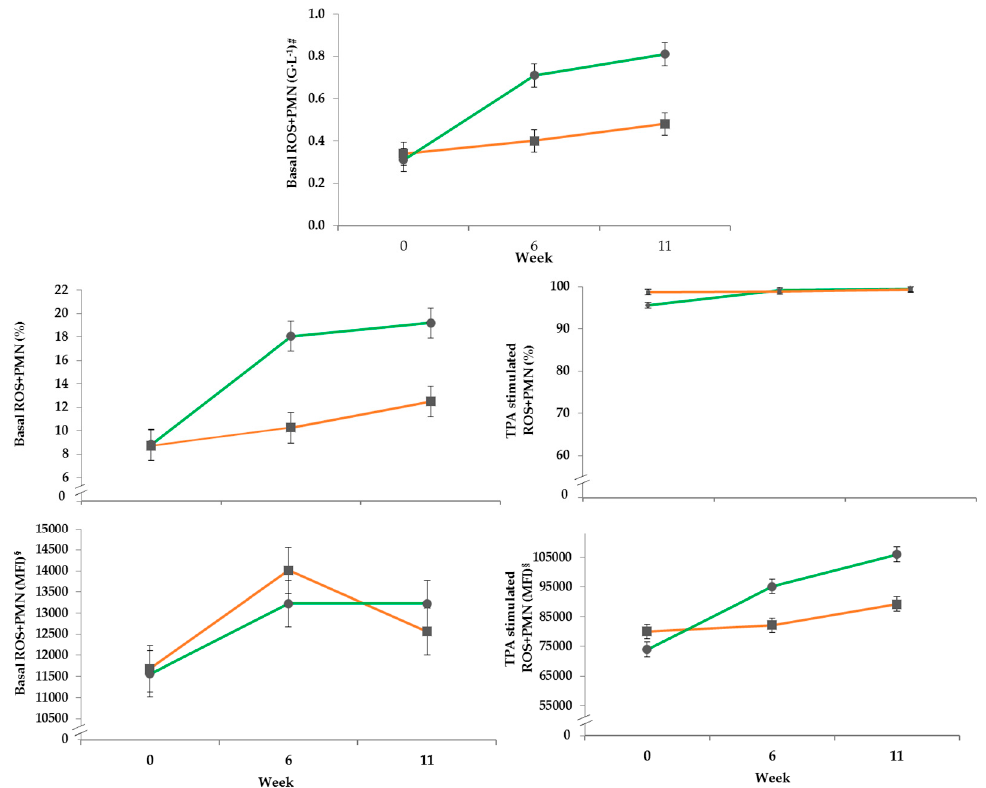
Figure 2. Effects of a ration change from an indoor based TMR to pasture on mean basal concentration (G·L -1 = 10 9 cells per liter) and proportion (%) as well as basal and stimulated mean fluorescence intensity (MFI) of polymorph nuclear leucocytes; all data points include standard error bars;  = pasture group (PG; n = 22, green);  = confinement group (CG; n = 21, orange). The results of the statistical analyses are shown in the accompanying table. The CG stayed on a TMR-based diet